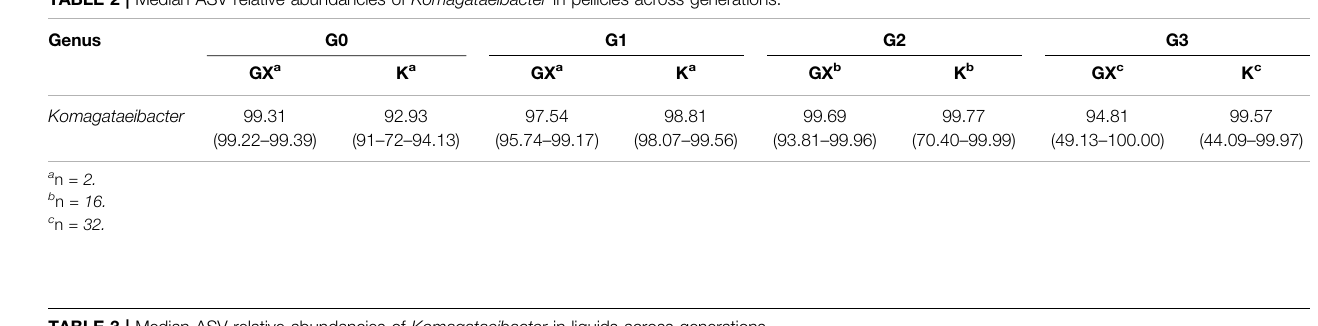
TABLE 3 | Median ASV relative abundancies of Komagataeibacter in liquids across